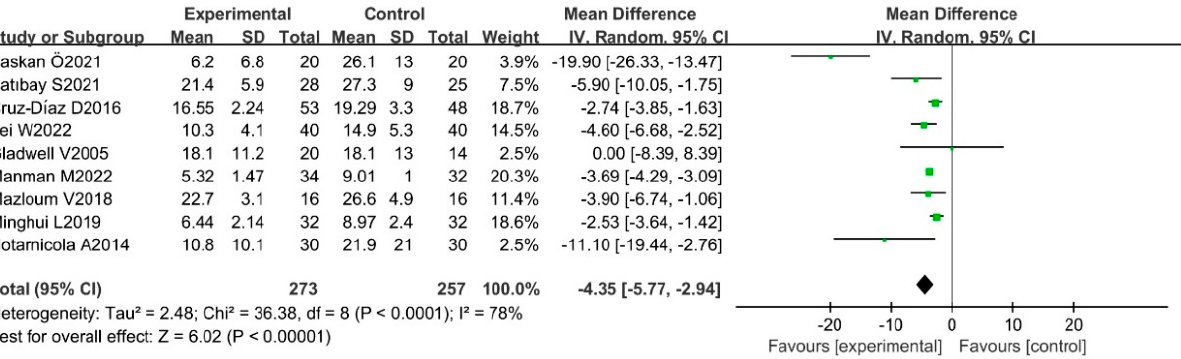
Figure 4. Meta-analysis of the effect of Pilates on Pain Scale in CLBP patients [12,18–23,36,43,45,48– 52,54,55].